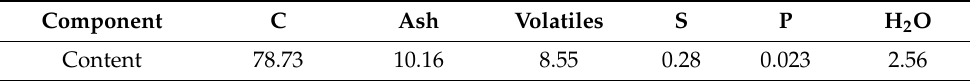
Figure 2. TG-DSC analysis of zinc ash. Table 2. Chemical composition of powder coal, wt.%.